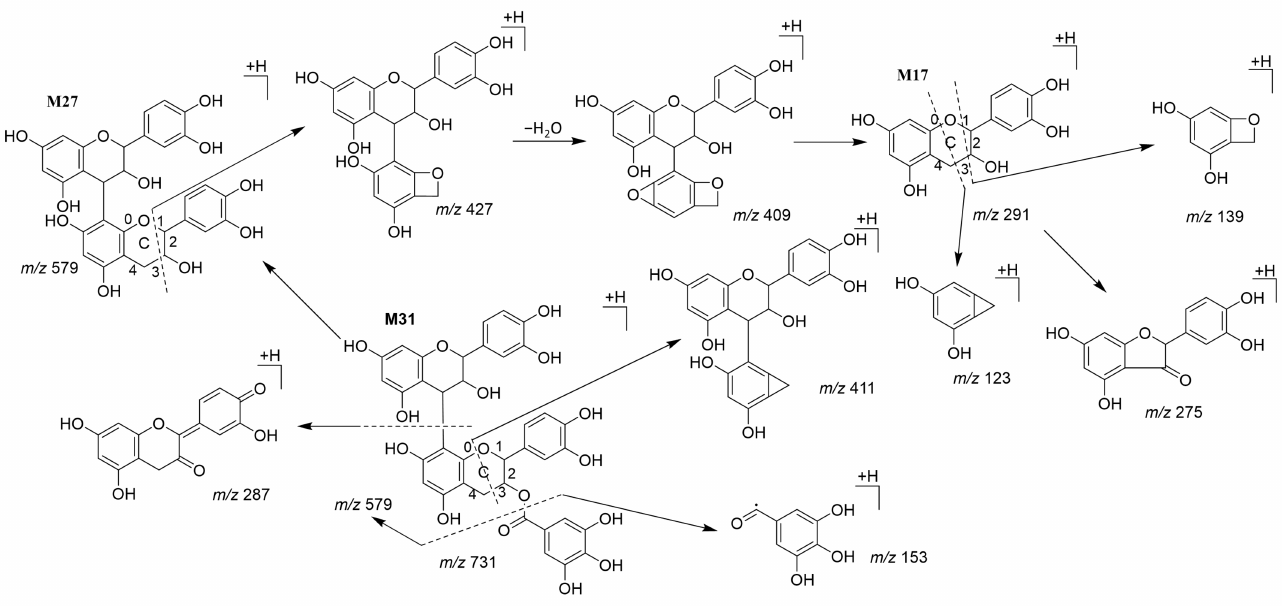
Figure 2. Fragmentation pathways of M17 , M27 , and M31